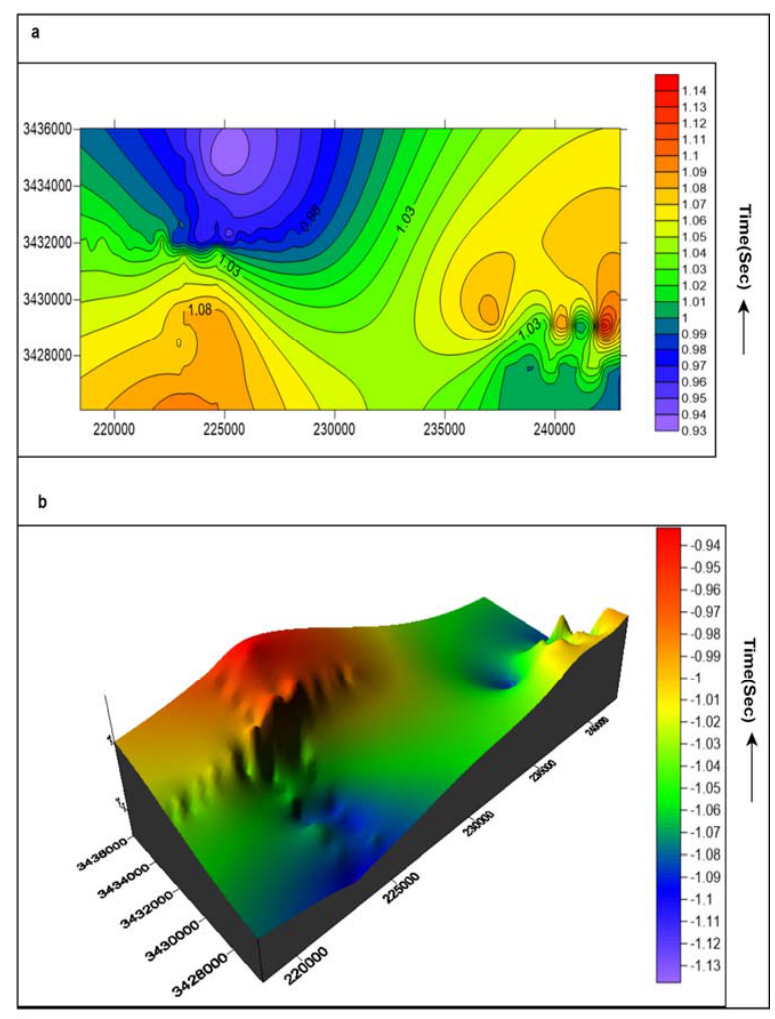
Figure 8 . ( a ) Time contour map of the Dunghan formation, ( b ) Time surface map of the Dunghan